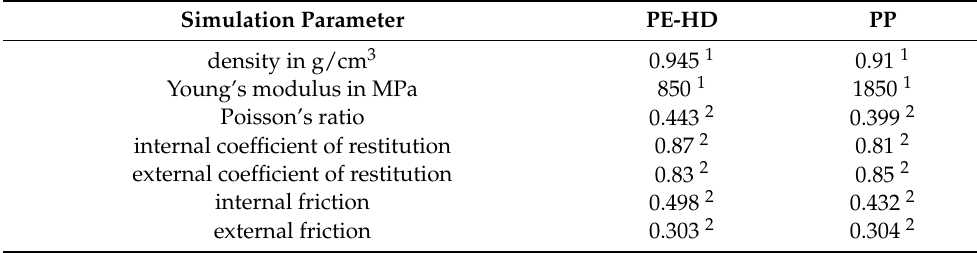
Table 2. Material parameters for the numerical